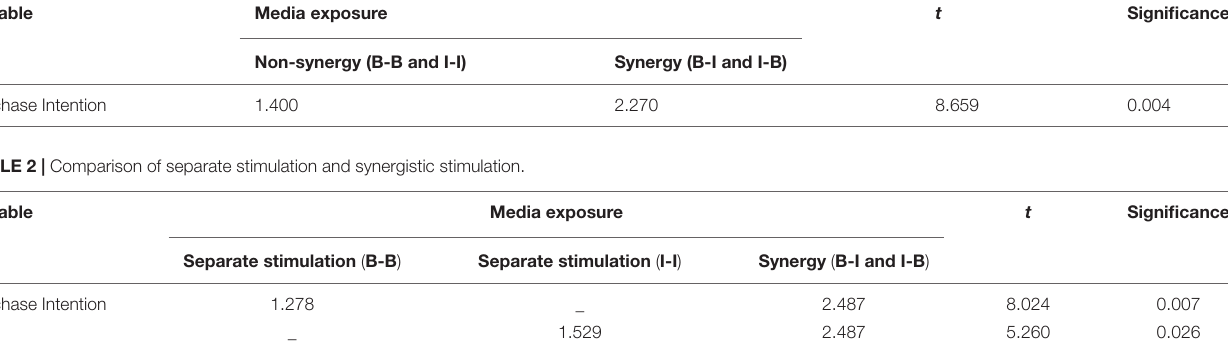
TABLE 1 | Comparison of synergistic stimulation and non-synergistic stimulation. Variable